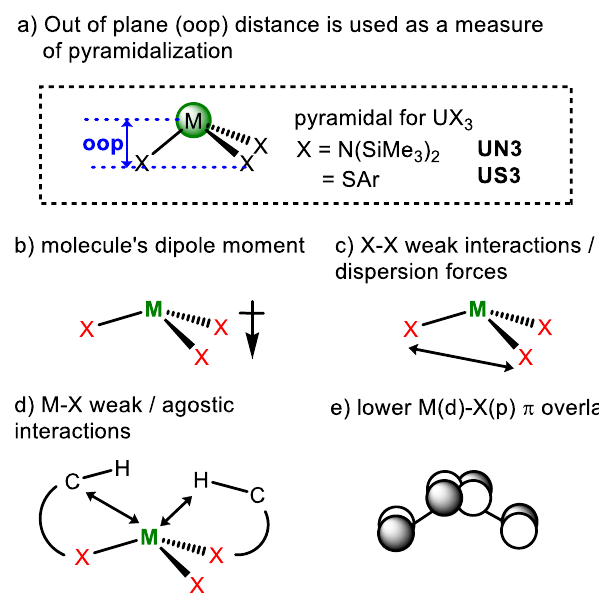
Fig. 1 Summary of the pyramidal molecules studied in this work and the factors thought to contribute to pyramidalization in Ln and AnX3 complexes. a Out of plane (oop) distance between the M and the X3 plane is described as oop, shown in blue, is used to provide a simple measure of pyramidalization in US3 and UX3. Contributing factors to pyramidalization in MX3 include b dipole moment, c ligand-ligand interactions, d metal-ligand agostic interactions and e M(d)-X(p) π overlap. UN3 = U(N(SiMe 3 ) 2 ) 3 and US3 = U(SAr) 3 where SAr = arylthiolate S- t Bu 3 − 2,4,6-C 6 H 2